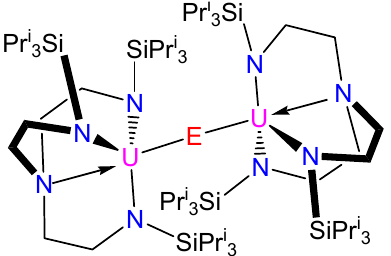
Figure 4. Structure of the diuranium U IV /U IV [{U(Tren TIPS )} 2 (µ-E)] (E = S, Se, Te) bridged-chalcogenide systems [37].